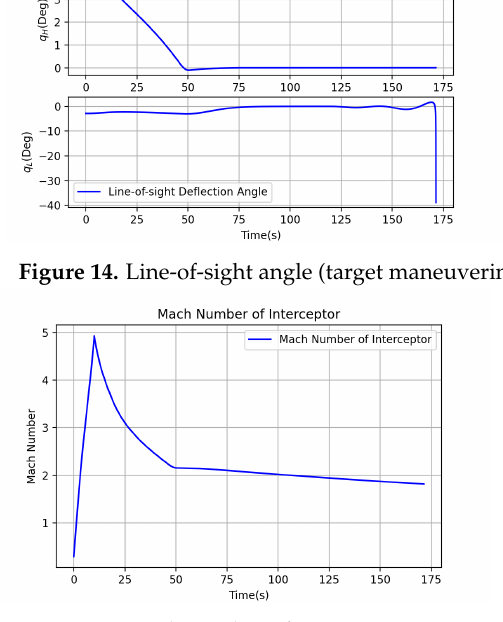
Figure 15. Mach number of interceptor.